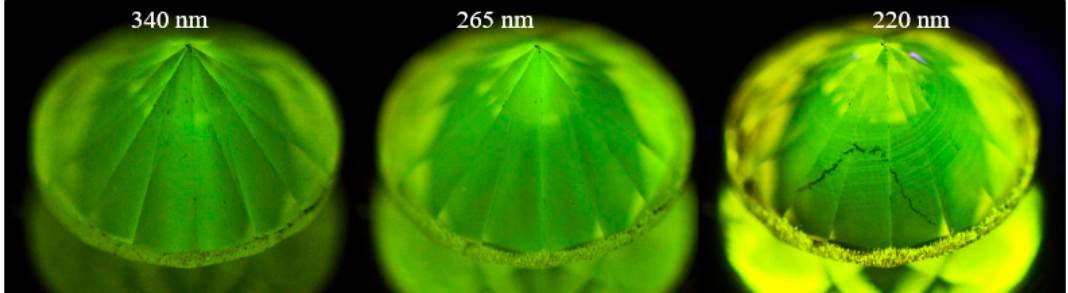
Figure 23. A pure type Ib brown diamond (sample TH 2.561) under three different UV excitations of the DFI system. The yellowish green PL is caused by the H3 defect, even though according to the IR spectrum the stone did not contain measurable A aggregate nitrogen.